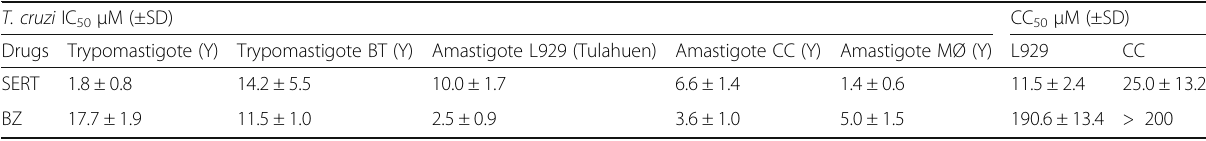
Table 1 Antiparasitic activity and mammalian cytotoxicity of sertraline T. cruzi IC 50 μ M